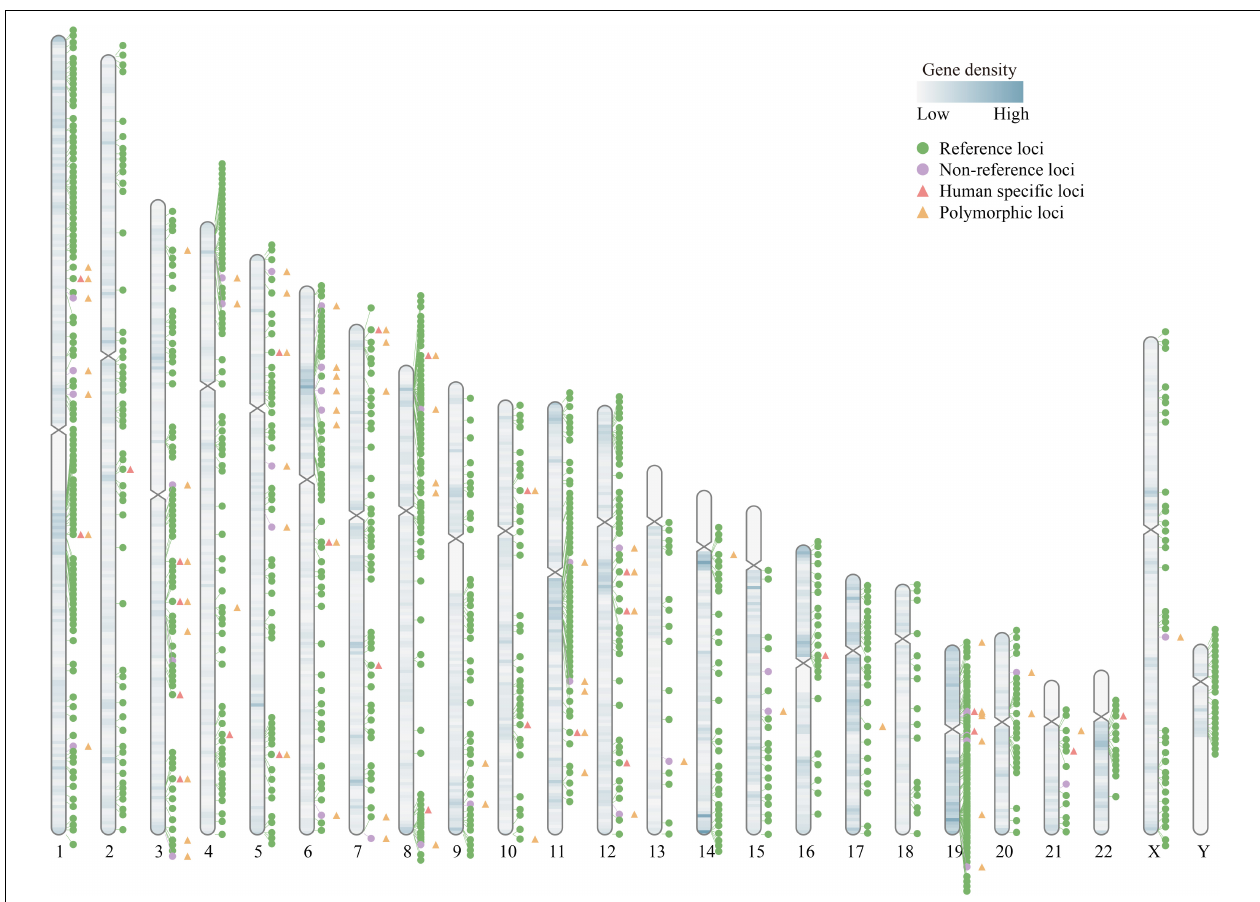
FIGURE 1 | Diagram of the genome wide distribution of HERV-K (HML-2). There are 1098 HERV-K (HML-2) loci in human genome, including reference (hg19) and non-reference loci. Among them, there are 26 reported human-specific loci and 71 polymorphic integration loci, which have been highlighted with different symbols in the figure (except one polymorphic locus, solo-LTR946, located in GL000219.1). Detailed information of all the 1098 HERV-K (HML-2) loci were summarized in Xue et al. (2020).